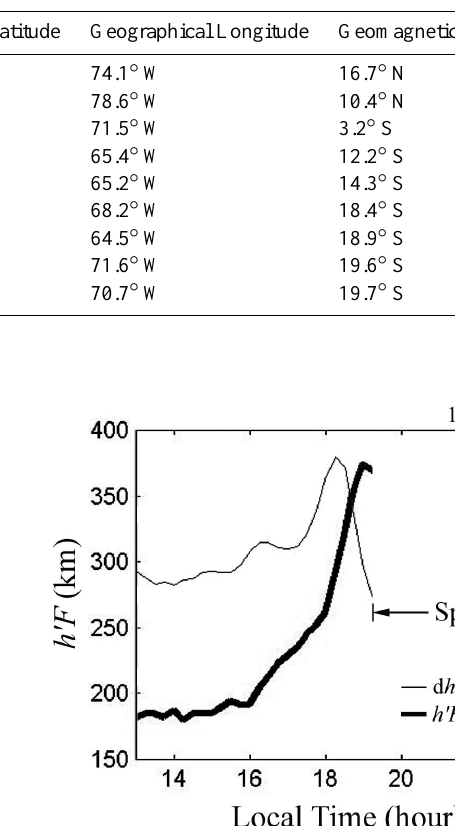
Table 1. The locations of the GPS stations on the west side of South America.